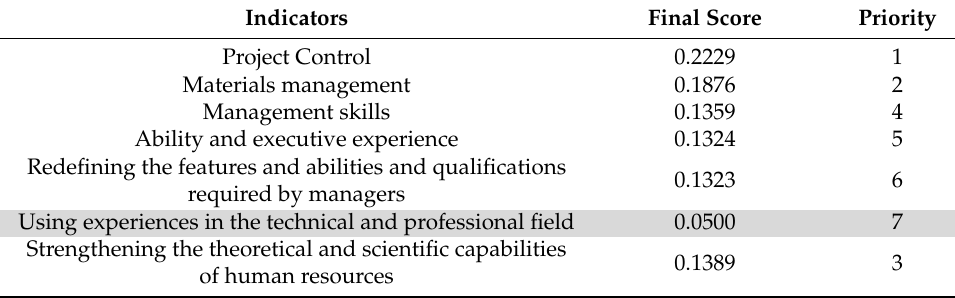
Table 7. Priority related to management